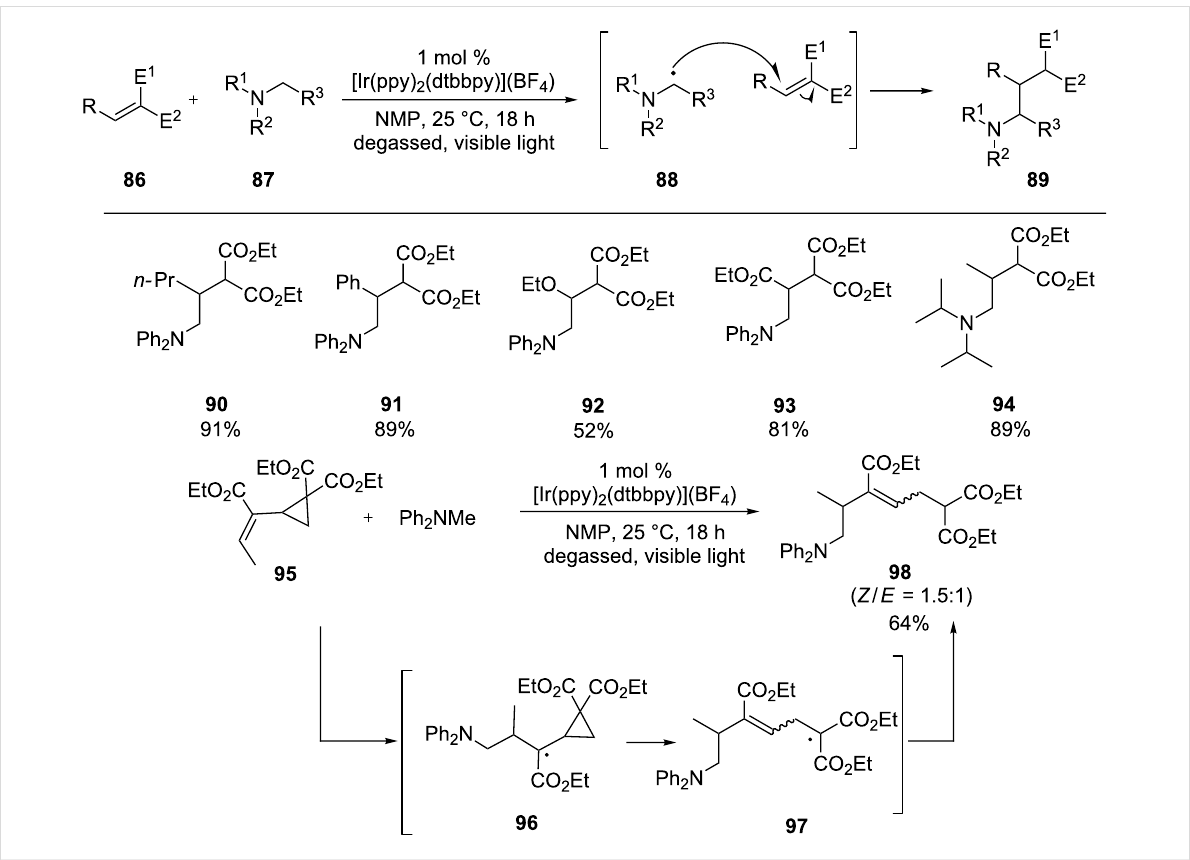
Scheme 24: Conjugated addition of α -amino radicals derived from anilines to Michael